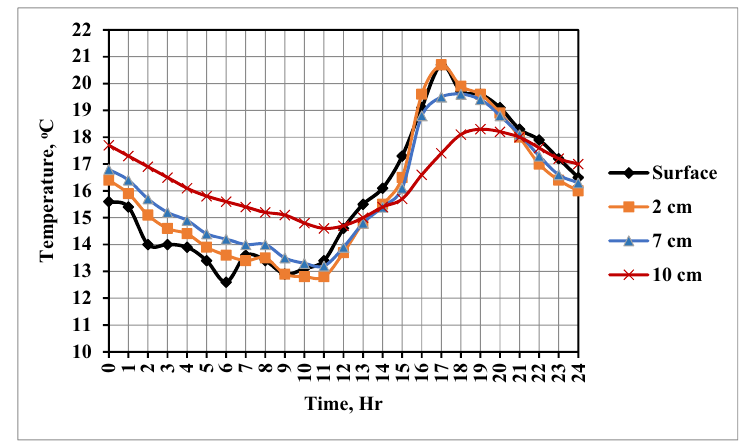
Figure 4: Relationship between the temperature and asphalt pavement thickness.